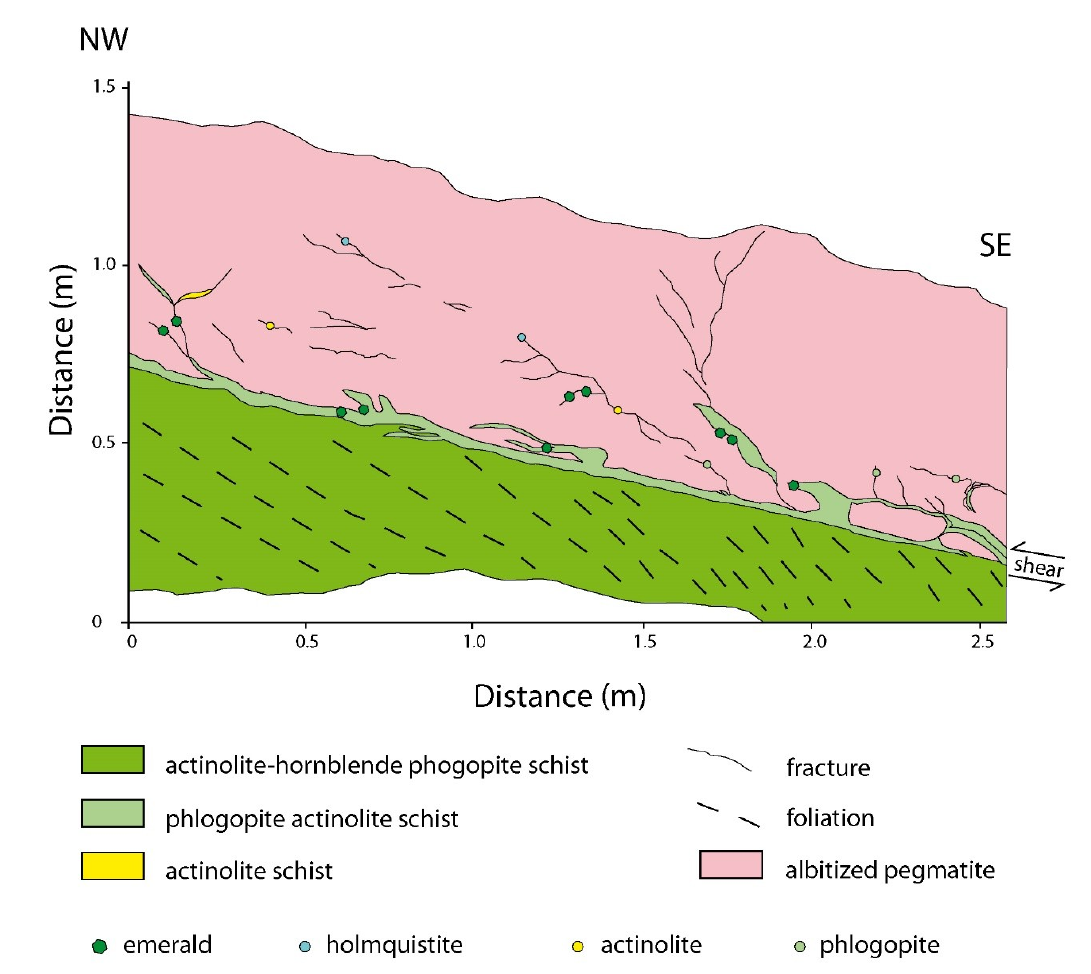
Figure 38. Cross-section of the mineralization at the Zeus underground mine, 200 ft. level, 26/28 stope, Sandawana deposit, Zimbabwe [167]. Fluids infiltrated along the schistosity of the actinolite-hornblende-phlogopite schist, and induced a metasomatic reaction with emerald formation at the foot wall of the